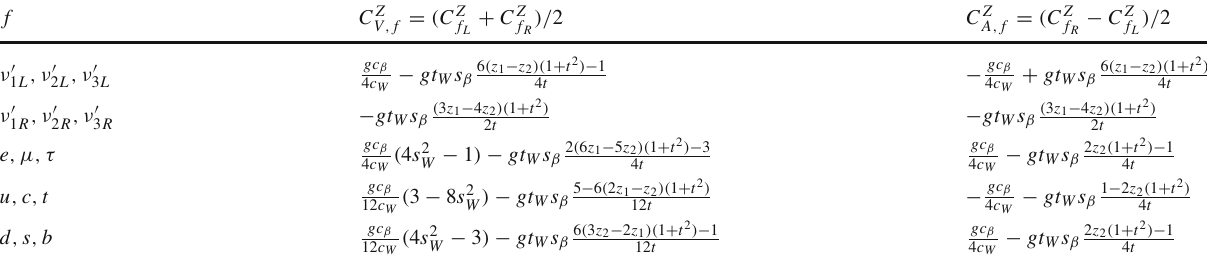
= ( C Z + C Z )/ 2 V , f f L f R